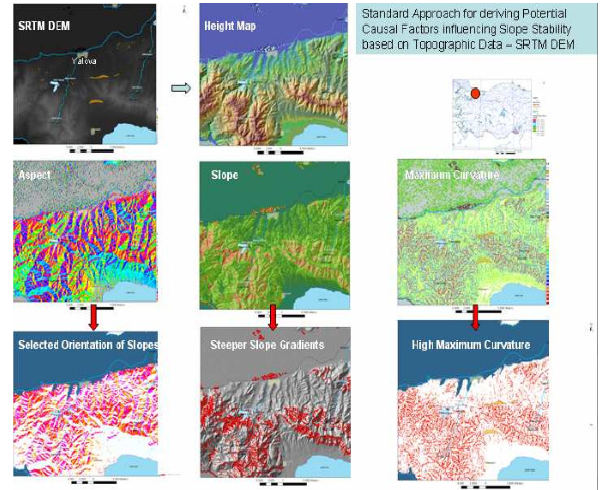
Figure 2 a. Morphometric maps based on SRTM data